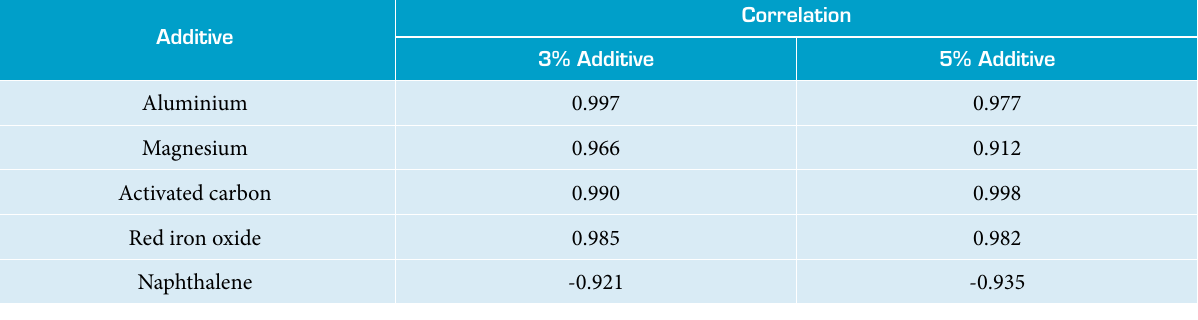
Table 4. Correlation between ignition delay time and particles size of the